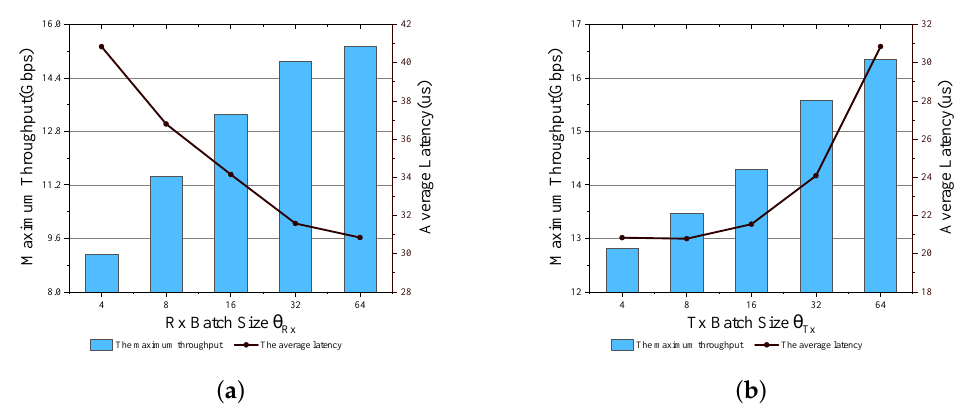
Figure 4. The performance of data plane with different Batch Size. ( a ) θ Tx = 64. ( b ) θ Rx = 64. Figure 5 shows the average latency of packets forwarded through the data plane under different input rates. For simplicity, we denote the average latency curve in Figure 5 by ( r ) . When the traffic rate r is in the range [1, 8] Gbps, T ( r ) , T ( r ) , T ( r ) , T θ θ Tx @8 θ Tx @16 θ Tx @32 Tx ( r ) almost overlap, so the θ and T θ Tx has little effect on the average latency of packets Tx @64 in this rate range. At the same time, we noticed that, in this range, the average latency of packets decreases with rate r . When r is in the range [10, 15] Gbps, the average latency of packets increase with the θ Tx . Moreover, in the range [8, 15] Gbps, the average latency of packets increases with rate r .